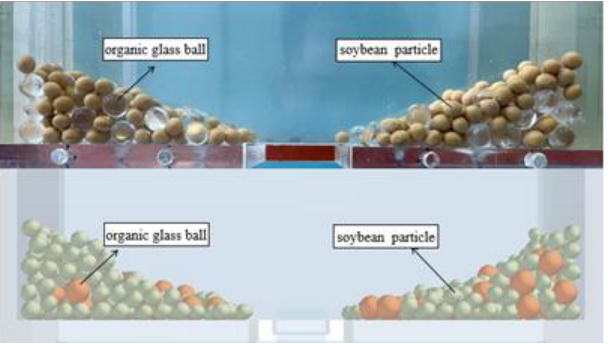
Figure 14. Test and simulation diagram of the repose angle of soybean seed particles mixed with organic glass spheres.